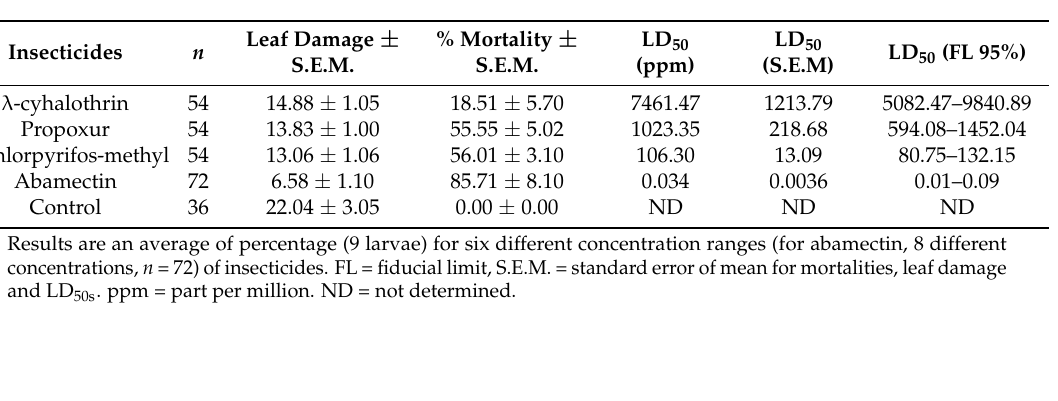
Table 2. Results of probit analyses for insecticides bioassay and leaf damage with various concentrations of insecticides.